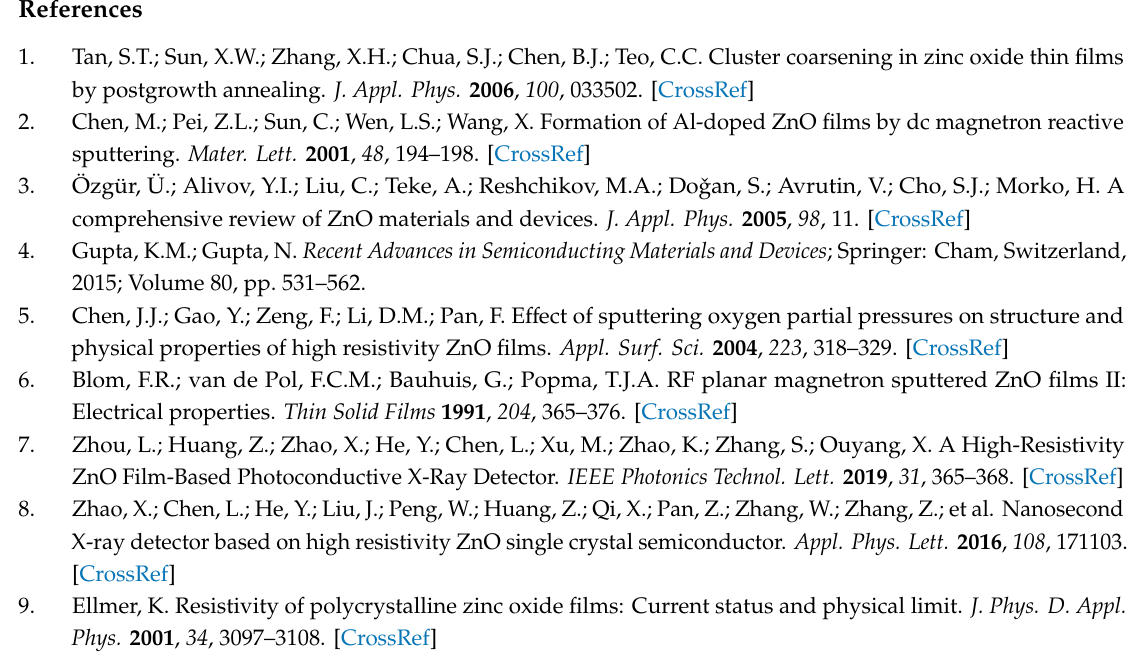
Figure S1: Detail illustration about dual-source RF magnetron sputtering system. Figure S2: Cross sectional SEM images of ( a ) C0, ( b ) C1, ( c ) C2, ( d ) C5, and ( e ) C10. There is no double layer detected in every thin film. Figure S3: Williamson-Hall plot of each sample. Seven XRD peaks of C0 ( a ), C1 ( b ), ( c ) C2, ( d ) C5, and ( e ) C10 were picked and linear-fitted using the least-square method. Table S1: Layer thickness measured using the stylus surface